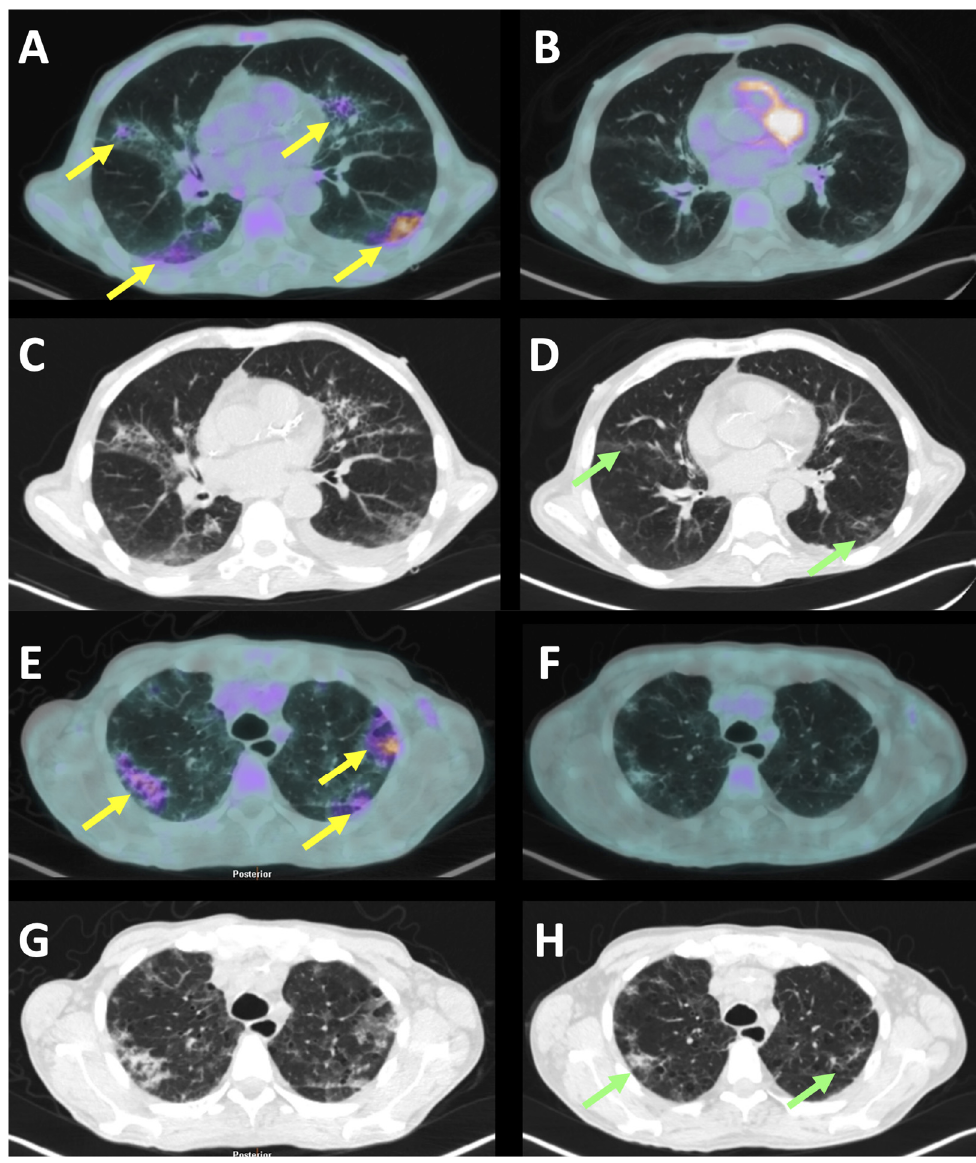
Figure 1. Axial section of the [ 18 F]FDG-PET/CT scan of patient A ( A – D ) and patient B ( E – H ) before the Tocilizumab infusion (left images) and 14 days after therapy (right images). Yellow arrows indicate the areas of interstitial pneumonia that were metabolically active at the FDG-PET. After therapy, despite the FDG-PET being completely negative, there were still some areas of ground-glass at the CT scan (green arrows). Indeed, the normalization of the CT scan always occurred later than the normalization of the FDG-PET, thus highlighting the importance of monitoring patients’ therapy by